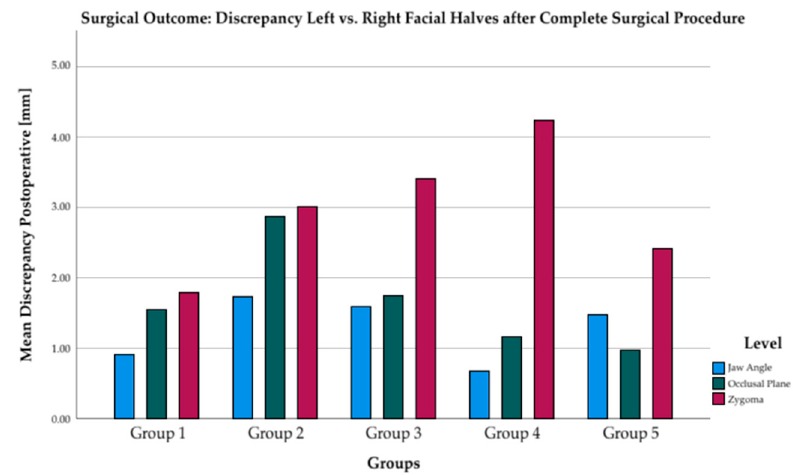
Figure 16. Linear distance discrepancy of left vs. right facial halves subdivided by all levels after surgical treatment in all five groups.